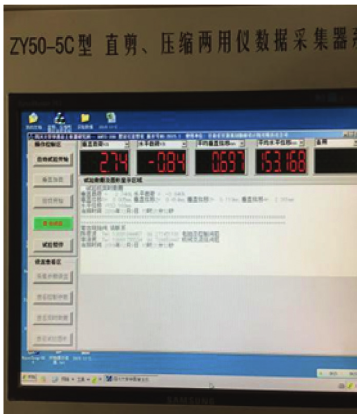
Figure 4: Software of the acquisition